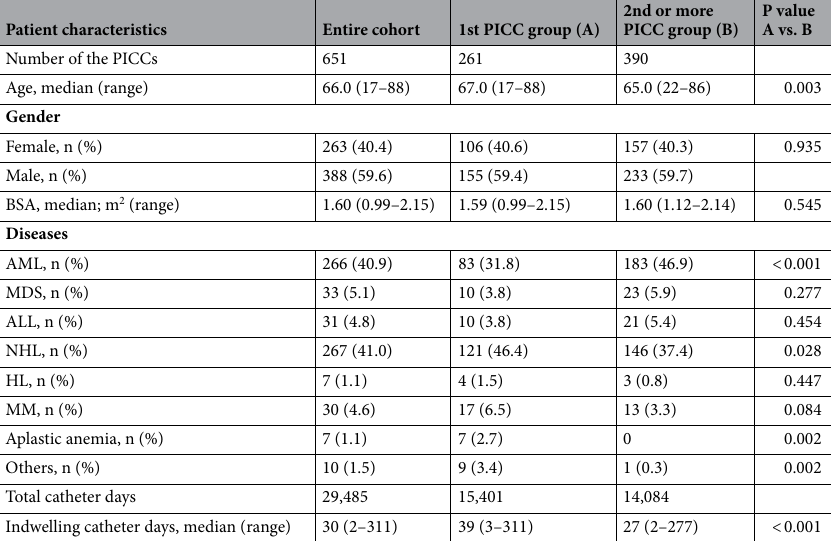
Table 1. Patient characteristics of entire cohort and each PICC insertion group. ALL acute lymphoblastic leukemia, AML acute myeloid leukemia, BSA body surface area, HL Hodgkin lymphoma, MDS myelodysplastic syndromes, MM multiple myeloma, NHL non-Hodgkin lymphoma, PICC peripherally inserted central catheter.